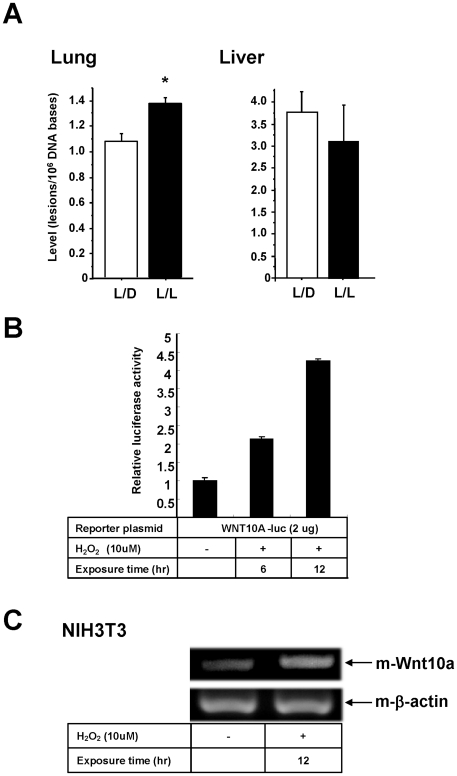
WNT10A is induced by oxidative stress.(A) 8-hydroxydeoxyguanosine levels are significantly increased in the lung tissues of L/L compared with L/D mice (*P<0.05). (B) Reporter assays. The promoter activity of the WNT10A gene was measured using a luciferase system after the addition of hydrogen peroxide. 42 hours after transfection (exposure time 6 hr) or 36 hours after transfection (exposure time 12 hr) of the reporter plasmid into PC3 cells, cells were treated with 10 µM of hydrogen peroxide. Luciferase activities were assayed after 48 hours of transfection. The results shown are normalized against protein concentrations measured using the Bradford method and are representative of at least three independent experiments. (C) Induction of mouse Wnt10a transcripts by oxidative stress. NIH3T3 cells were treated with or without H2O2 (10 µM) for 12 hours. Total RNAs were assayed by semi- quantitative RT-PCR. Mouse β-actin was used for internal control.